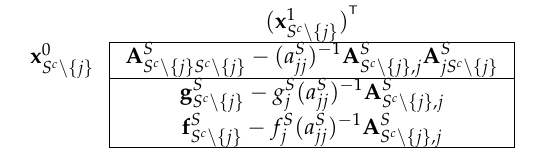
Table 5. Minimal tableau for S ∪ { j } -active BFS, obtained after pivoting on a S